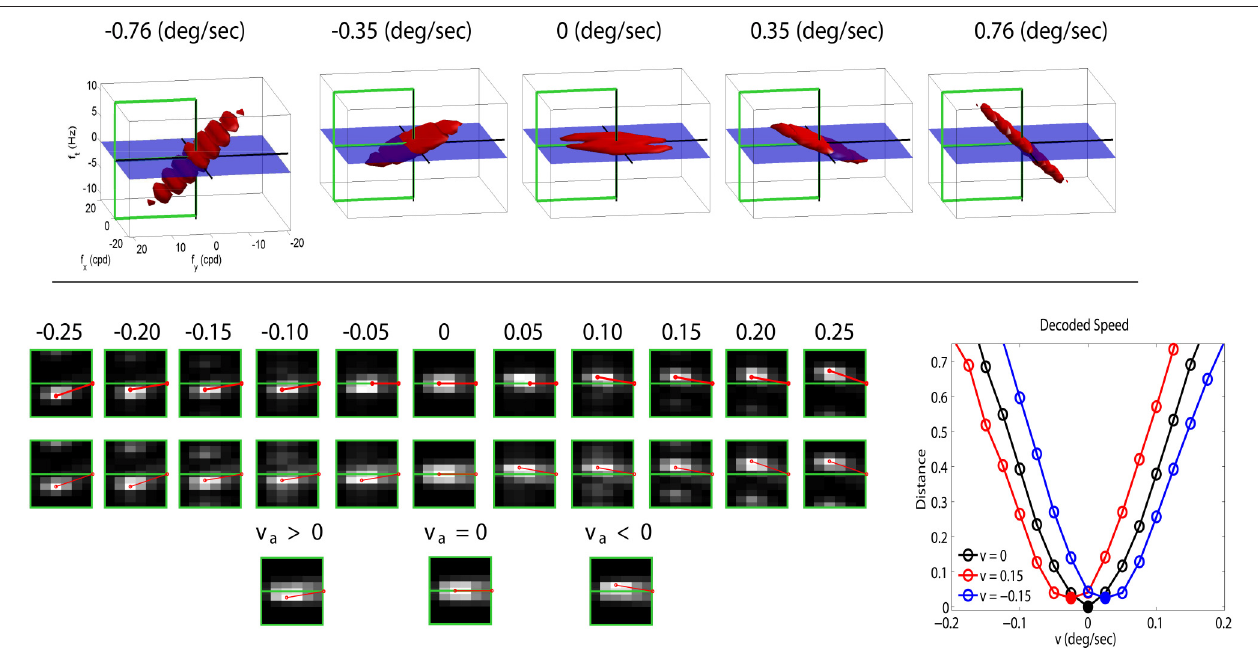
FIGURE 3 | Motion aftereffect in sensors with divisive normalization. Top (stimuli) shows examples of noise sequences moving at different vertical speeds in the Fourier domain. Due to the properties of 3- d Fourier transform, speed induces progressive inclination in the spectrum with regard to the f t = 0 plane. We used a cut-off frequency of 18 cpd to prevent aliasing. Bottom-left (responses) first row shows the linear responses of the sensors tuned to frequencies in the (0 , f y , f t ) plane for a series of noise sequences (such as those in the top panel) with the speed represented by the numbers (in deg/sec). The response of the filters is scaled by the standard deviation of the amplitude of natural sequences. This is just a convenient contrast definition so that response amplitudes roughly cover the [ − 1, 1] range for every frequency. Consistently with the spectra, speed induces progressive imbalance in the linear responses above and below the f t = 0 plane. Second row shows the corresponding nonlinear responses when no prior adaptation is considered, i.e., c a = c in the denominator of Equation (2). The nonlinear stage also presents a characteristic correspondence between imbalance of the response pattern and speed. Third row shows the response pattern to a static input in three different adaptation situations: adaptation to positive speed ( v a > 0 ), no prior adaptation ( v a = 0 ), and adaptation to negative speed ( v a < 0 ). Bottom-right (speed decoding plot) shows the distances (Equation 3) between the responses to static patterns (3rd row in the response panel) and the set of possible responses under no adaptation (2nd row in the response panel). A Different line style corresponds to a different adaptation state (zero, positive, and negative) and the minimum indicates the decoded speed (zero, negative, and positive). The sign reversal is the motion